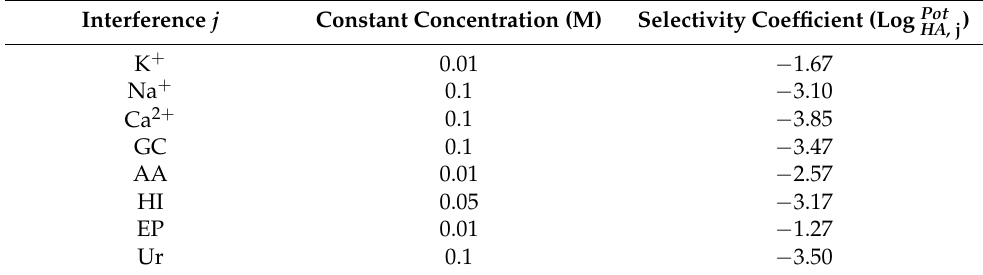
Table 3. Selectivity coefficients for K + , Na + , Ca 2 + , GC, AA, HI, EP and Ur. Interference